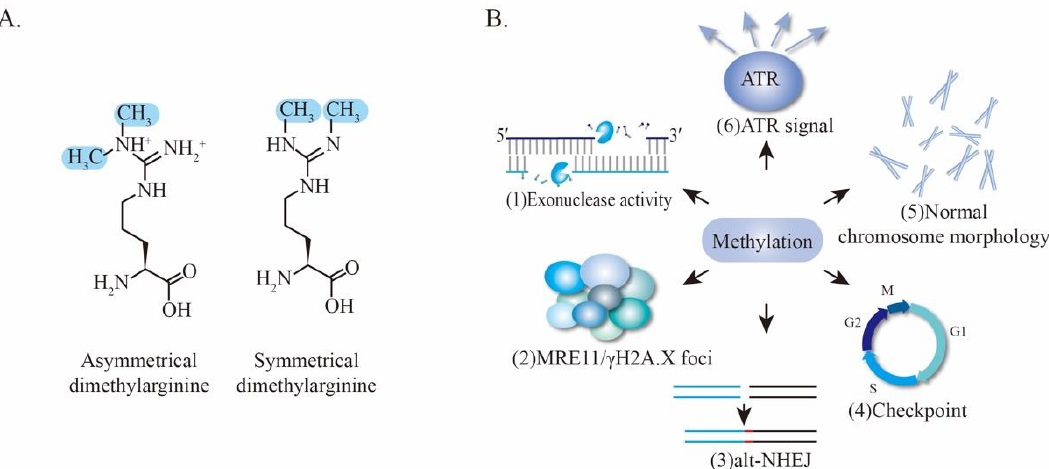
Figure 6. The effect of methylation of MRE11. ( A ) Asymmetric methylation and symmetric methylation on arginine. ( B ) The effect of MRE11 methylation, including regulating exonuclease activity, forming DNA repair foci, promotion of alt-NHEJ, regulating cell-cycle checkpoint, maintaining normal chromosome morphology, signaling of ATR, and so on. Note that the image of (3)alt-NHEJ shows a simplified progress, and is different from canonical NHEJ.